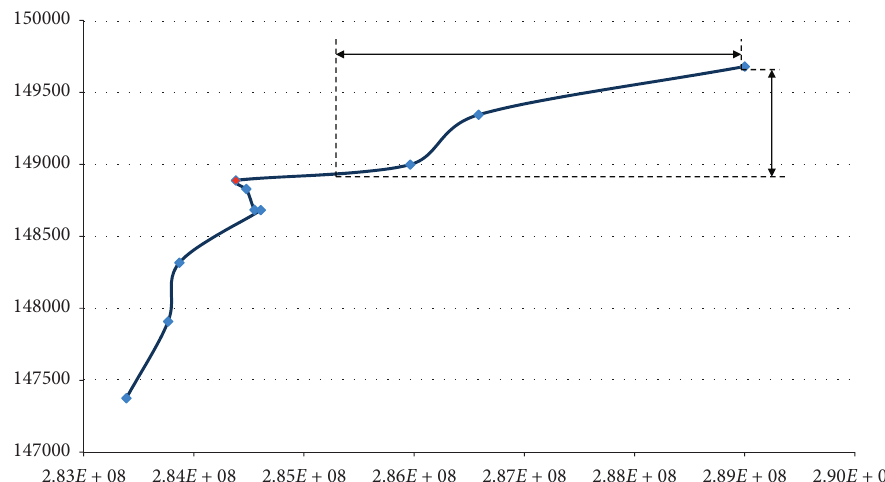
Figure 10: Pareto optimal curves of economic and environmental